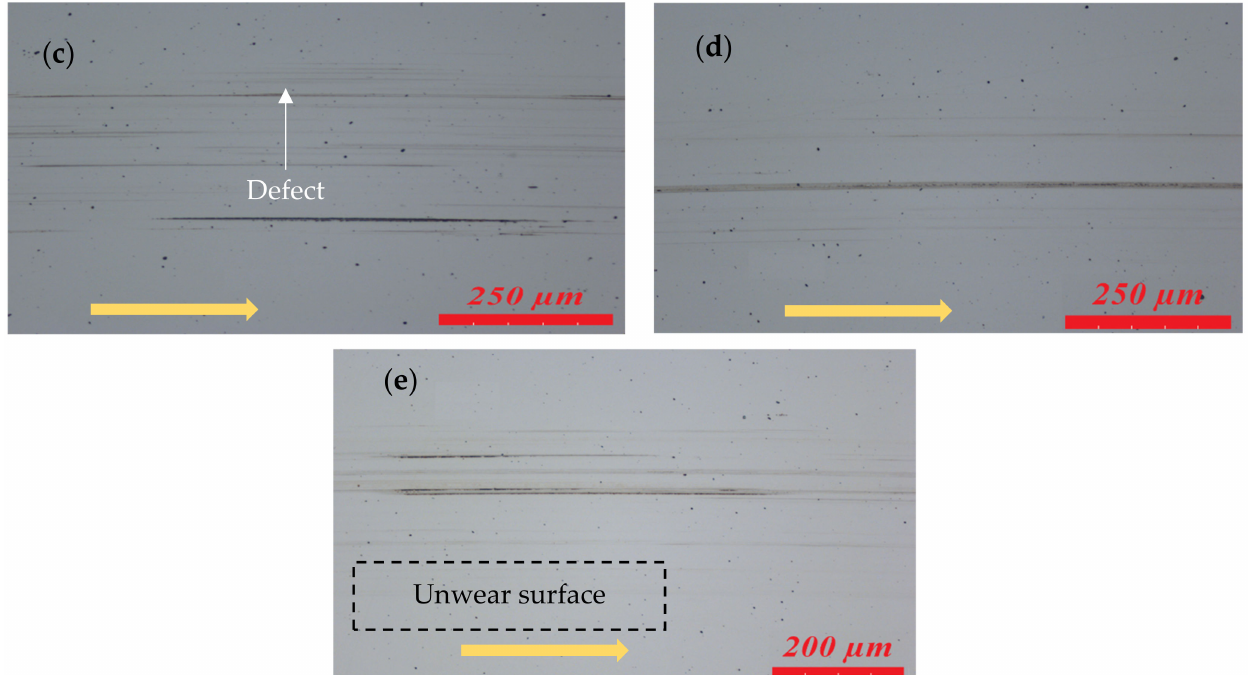
Figure 5. Optical micrographs of the wear surfaces on the discs from tests lubricated with the ionic liquid and different concentrations of CuO and ZnO nanoparticles: ( a ) IL, ( b ) IL + 0.2 wt% CuO, ( c ) IL + 0.5 wt% CuO, ( d ) IL + 0.2 wt% ZnO, and ( e ) IL + 0.5 wt% ZnO. The yellow arrows on the images show sliding directions in the wear